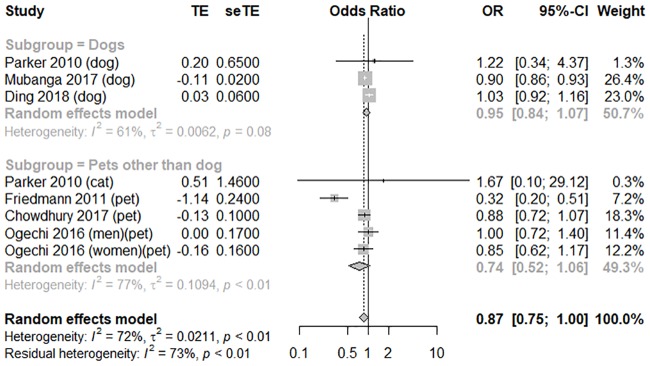
A forest plot of adjusted cardiovascular mortality, comparing pet owners and non-pet owners, with a subgroup analysis by pet type.CI, confidence interval; OR, odds ratio; SE, standard error; TE, treatment effect.